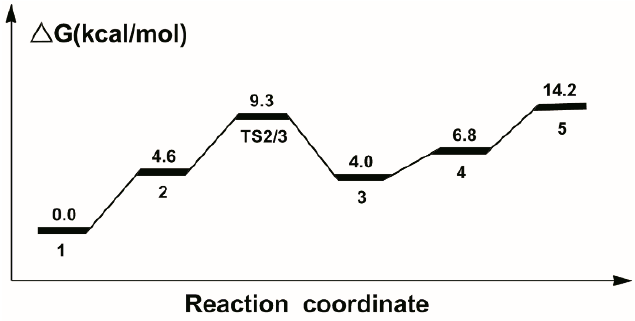
Figure 2. Calculated relative free energies in the catalytic process for the hydrogenation of CO 2 to formic acid.